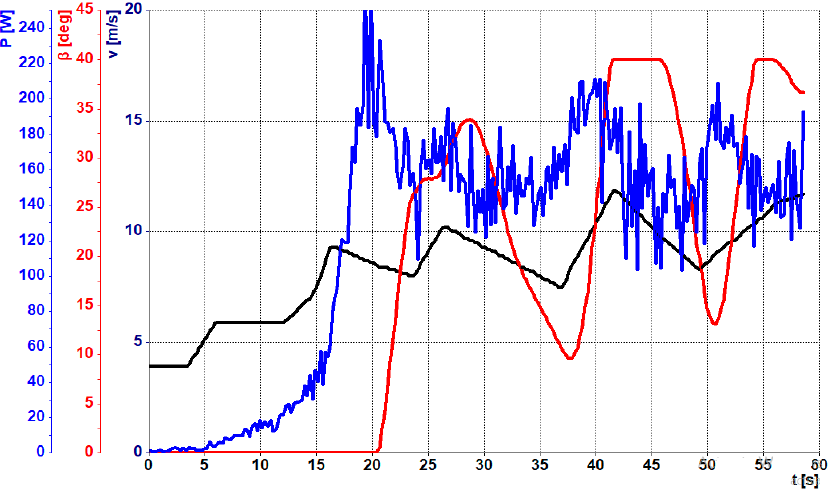
Figure 6. Wind speed, active power, and blade angle of second experimental case study.